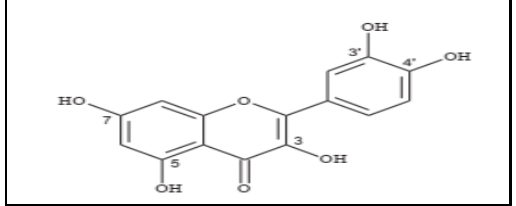
Figure 1. Structure of Quercetin Lead (Pb) is one of the most abundant heavy metal pollutants in the environment and it’s considered to be one of the most hazardous chemicals for humans and animals health (15)